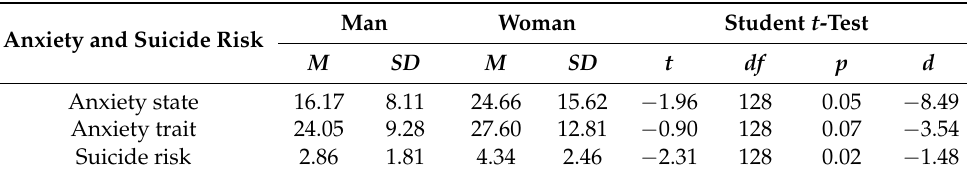
Table 2. Contrast of means (Student t -tests) to analyze differences in function of gender in the variables of the study. Man Woman Student t -Test Anxiety and Suicide Risk M SD M SD t df p d Anxiety state 16.17 8.11 24.66 15.62 − 1.96 128 0.05 − 8.49 Anxiety trait 24.05 9.28 27.60 12.81 − 0.90 128 0.07 − 3.54 Suicide risk 2.86 1.81 4.34 2.46 − 2.31 128 0.02 −